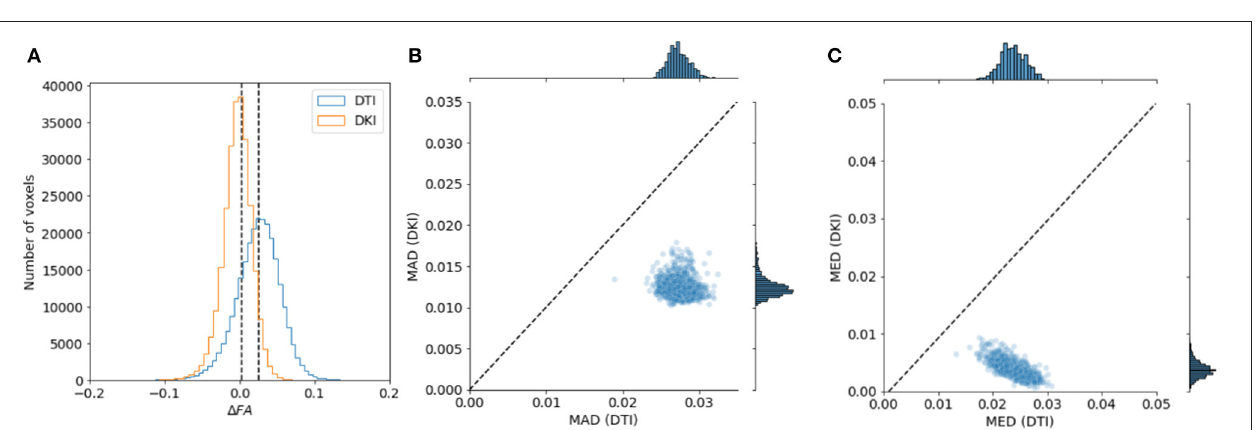
FIGURE 8 | Comparing DTI And DKI goodness of fit in the Human Connectome Project dataset. Within a typical single individual (A) , the distribution of AICs displayed. Dashed line indicates the median of each distribution. (B) AIC is also consistently lower for DKI than for DTI for all subjects in the dataset who have measurements of DWI. (C) This holds, though the effect is substantially smaller, when the DTI model is fit only to data with b = 1,000 s / mm 2 .